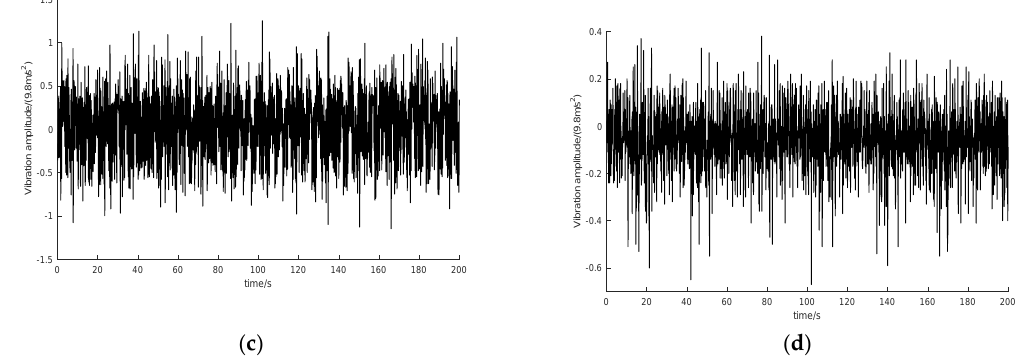
Figure 8. Vibration signals of four measuring points. ( a ) measuring point 1, ( b ) measuring point 2, ( c ) measuring point 3, and ( d ) measuring point 4.